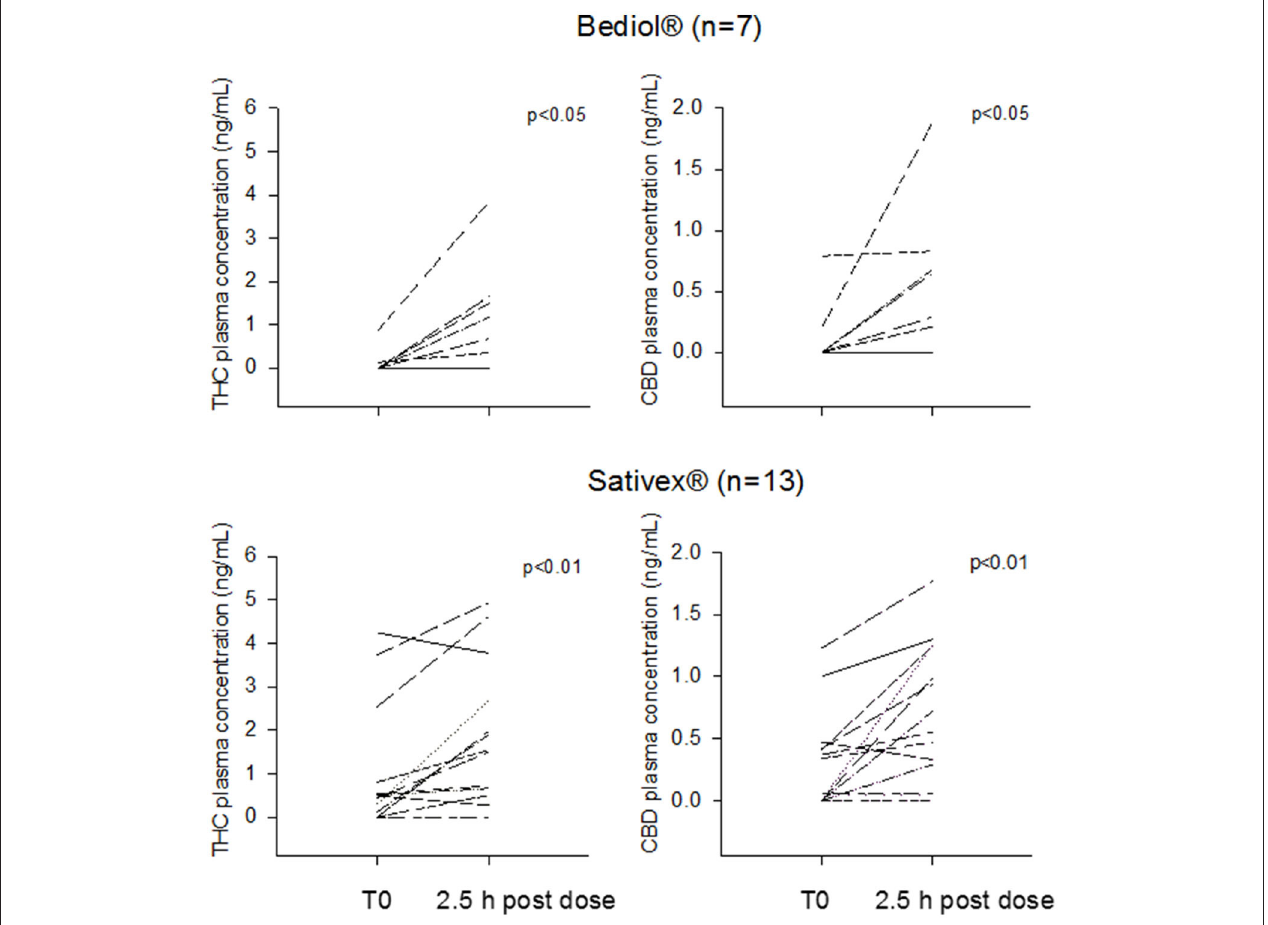
FIGURE 2 | Intrasubject tetrahydrocannabinol (THC) and cannabidiol (CBD) morning trough and 2.5h post-dosing plasma concentrations grouped by patients treated with Bediol ® and Sativex ®